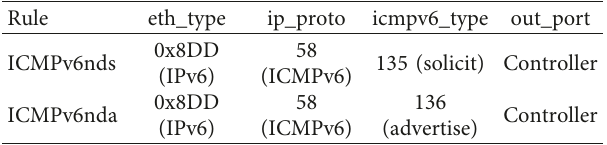
Table 3: IPv6 address resolution